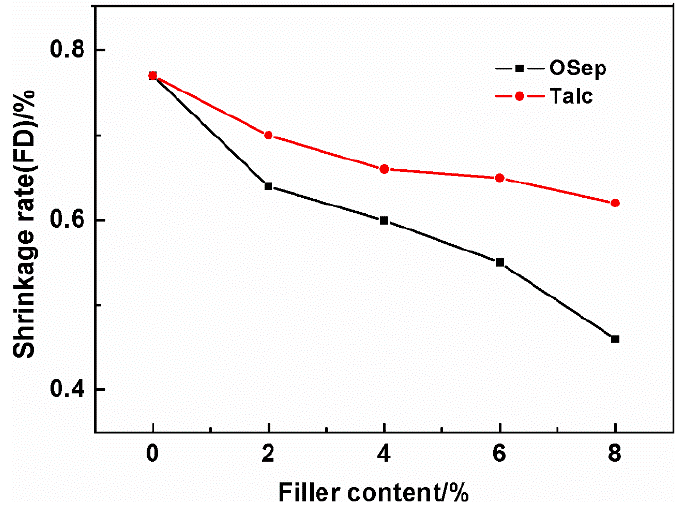
Figure 12. Shrinkage rate (FD) of PP materials with different filler contents.